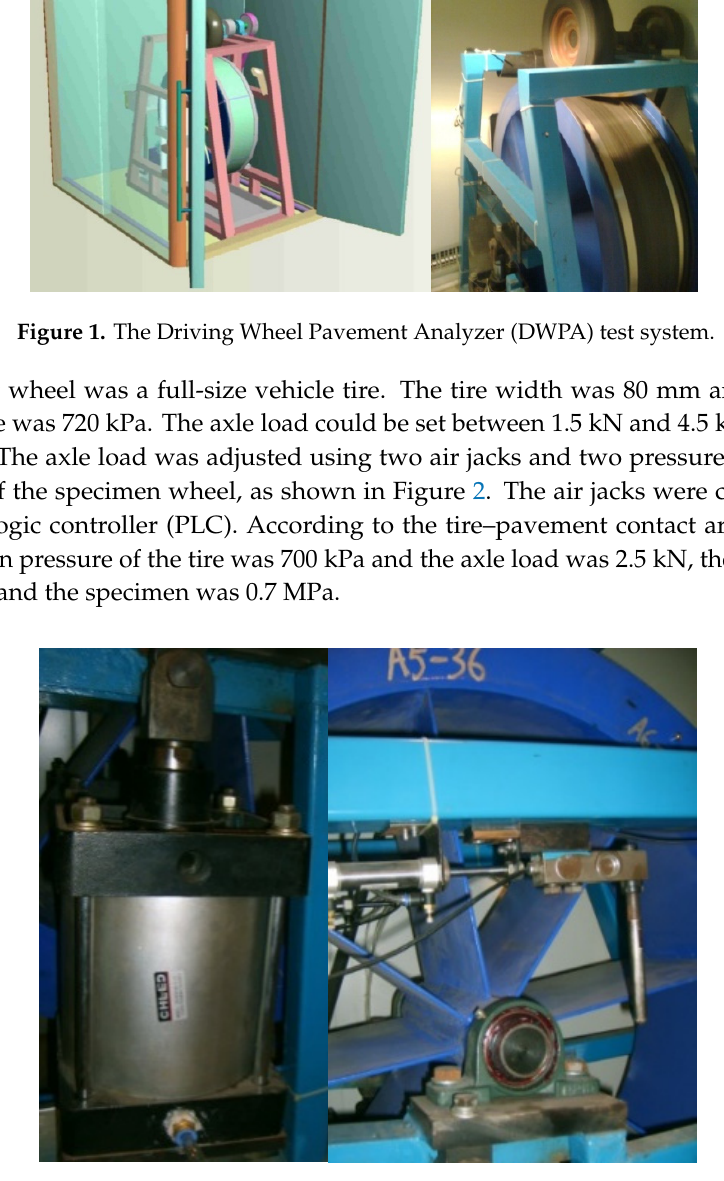
Figure 2. The air jacks and pressure sensors.